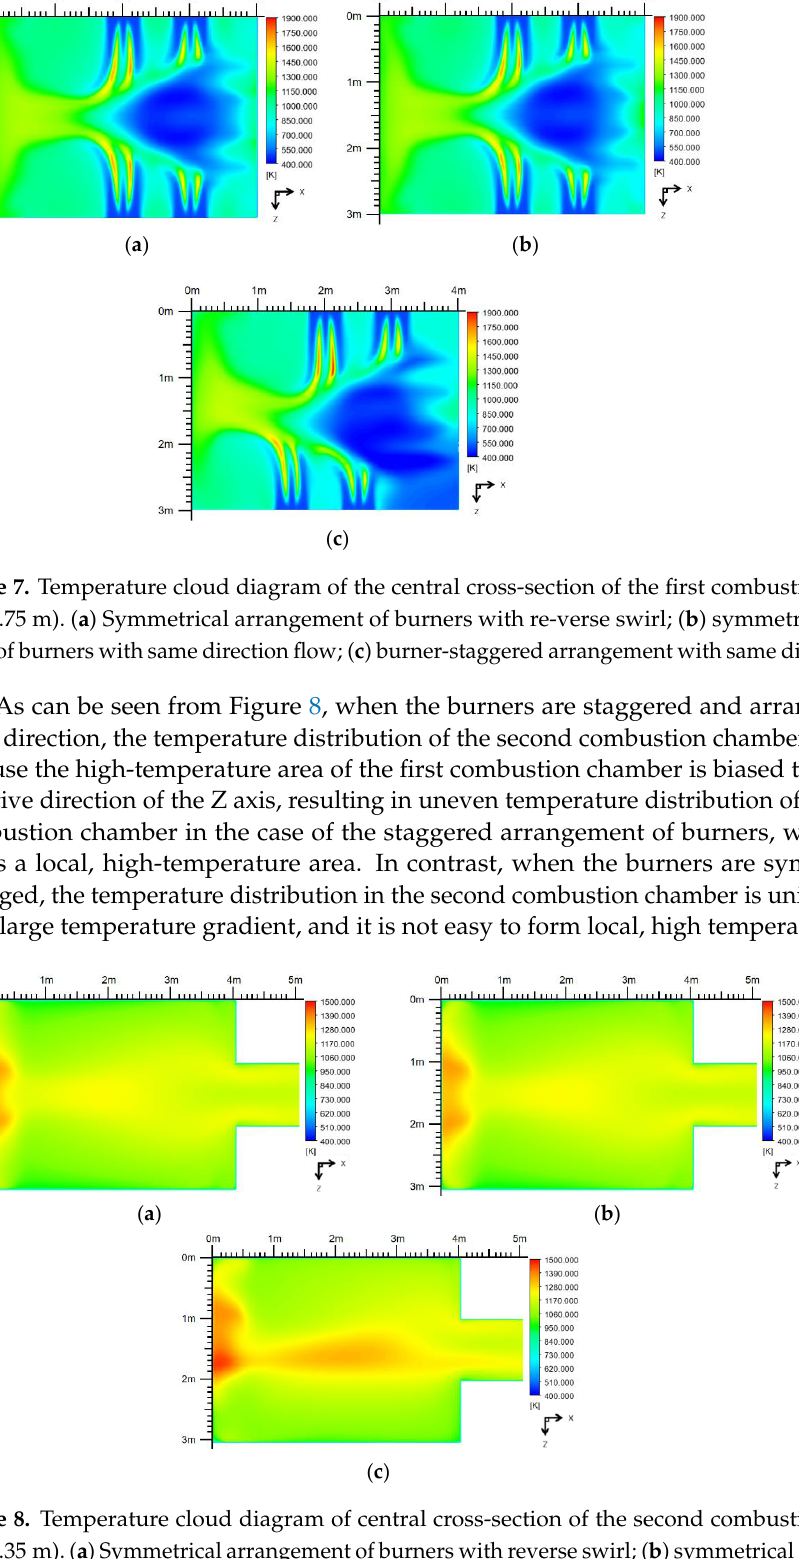
c Figure 6. The complete combustion ratio of concentrated liquid under three different burner ar- rangements: (a) symmetrical arrangement of burners with reverse swirl; (b) symmetrical arrange- ment of burners with same direction flow; (c) burner-staggered arrangement with same direction flow. In Figure 7, the temperature distributions of the central cross-section of a combustion chamber under three different arrangements of the burner are shown. When the burners are arranged symmetrically, regardless of the same direction or the reverse swirl flow, there is a large area of low temperature in the central cross section of a combustion cham- ber from X = 2.5 m to X = 4 m. This is because the concentrated liquid droplets enter the incinerator after atomization, absorb heat and evaporate in this area and then absorb a lot of heat, resulting in low temperatures in this area. At X = 2.5 m, most of the concentrated